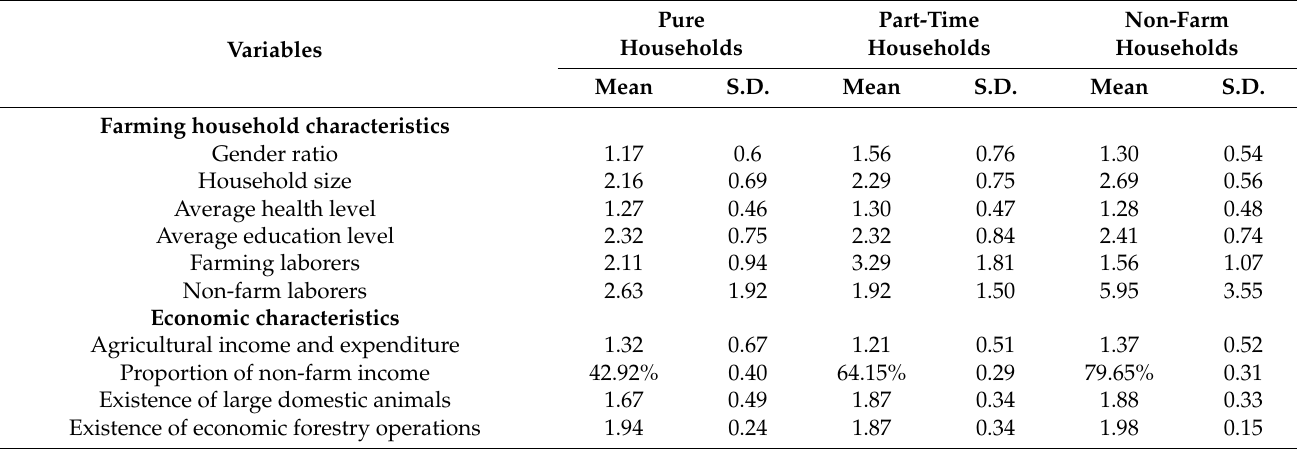
Table 4. Songhu Township (plain topographic